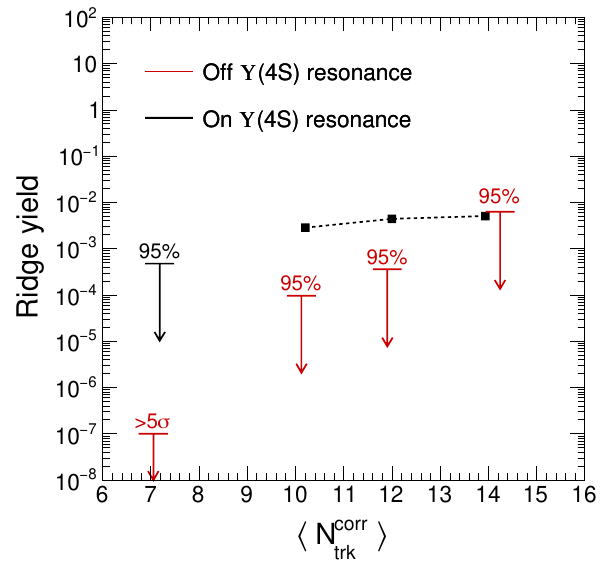
Figure 9. Central values (square markers for on-resonance) or upper limits of the ridge yield as a function of h N corr i for the off-resonance (red) and on-resonance (black) datasets for the thrust axis trk analyses. The associated uncertainties with the measured ridge-yield central values are smaller than the symbols. The label “ > 5 σ ” indicates a 5 σ confidence level upper